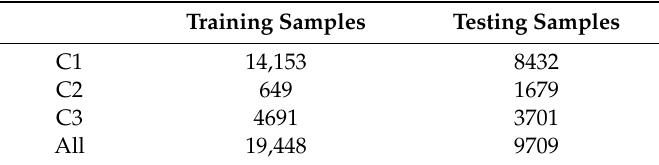
Table 3. Number of samples selected for training and testing.